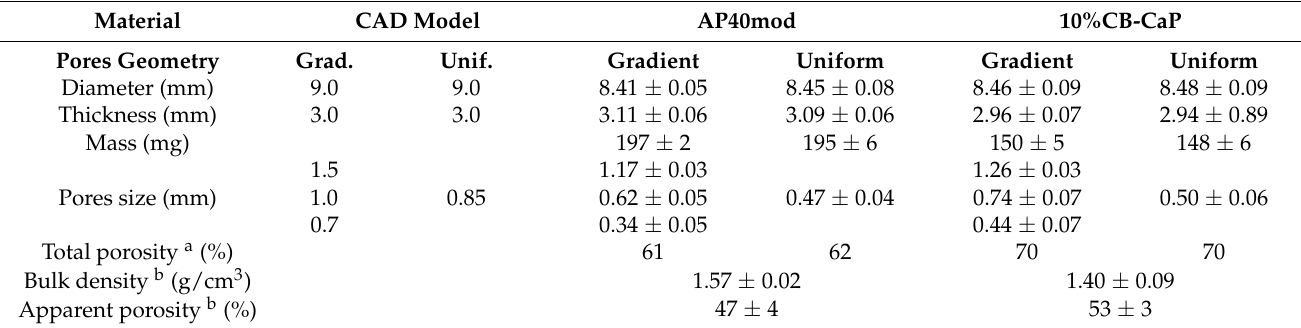
Figure 6. Picture of sintered scaffolds of AP40mod ( A ) and optical microscope pictures of the AP40mod scaffolds with two geometries: gradient pores ( B , D ) and uniform pores ( C , E ). Scaffolds of 10%CB-CaP look very similar to the AP40mod ones. Table 1. Dimensions, mass, density and porosity of the